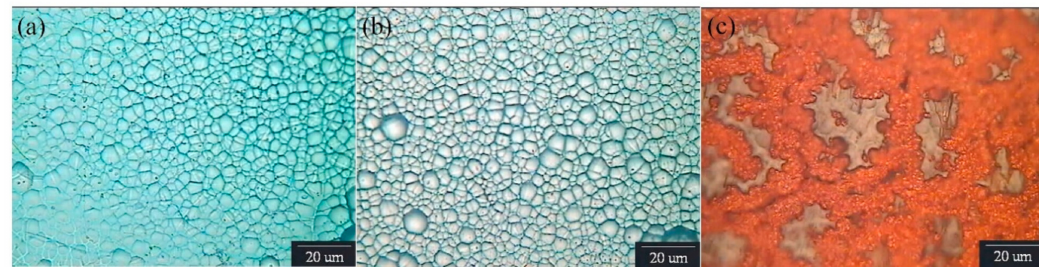
Figure 12. Surface morphologies of the ( a ) non-heated Cr–C / Cu-coated samples without pre-etching at 0.5 V and the ( b ) pre-etched non-heated and ( c ) pre-etched heat-hardened Cr–C / Cu-coated samples after immersion tests in 200 g / L CuSO 4 · 5H 2 O + 70 g / L H 2 SO 4 solution.